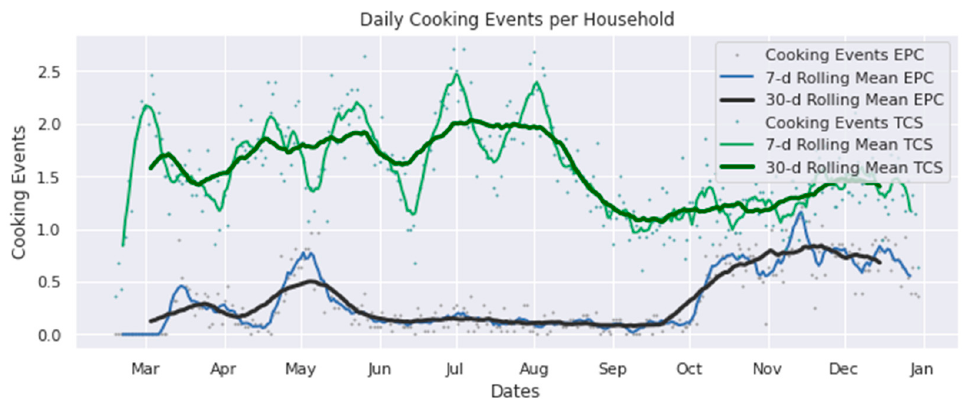
Figure 11. Time series of TCS and EPC events per day (averaged across 28 households).